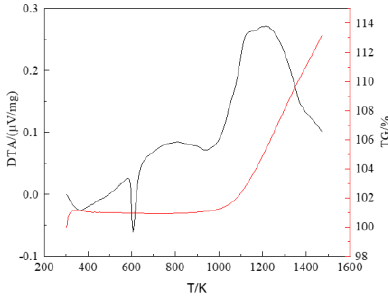
Figure 1. DTA–TG curve of 3Ti:B 4 C powder from room temperature to 1500 Figure 1. DTA – TG curve of 3Ti:B 4 C powder from room temperature to 1500 K. Based on the results of DTA, the detailed processing procedures for (B 4 C+Ti)/Mg and (B 4 C+Ti)/AZ91D composites by the in situ reactive infiltration method can be summarized as follows. Firstly, Ti and B 4 C powders (in a molar ratio of 3:1, as shown in their equilib- rium reaction equation 3Ti + B 4 C = TiC + 2TiB 2 ) were mixed and mechanical blended after